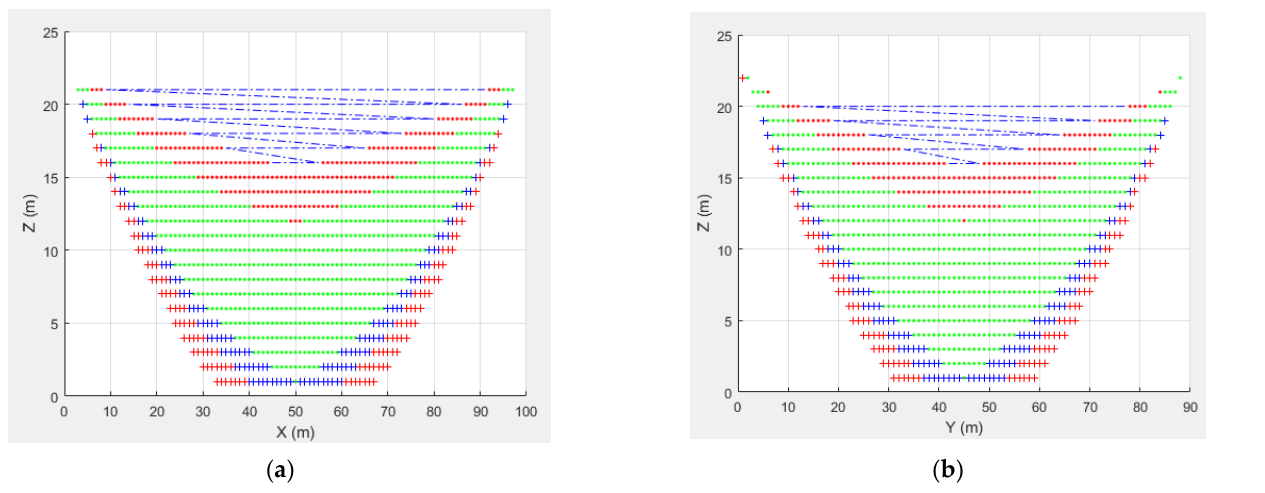
Figure 3. MCTs on the workspace sections: ( a ) MCTs on the plane y = 45 m, ( b ) MCTs on the plane x = 50 m. plane x = 50